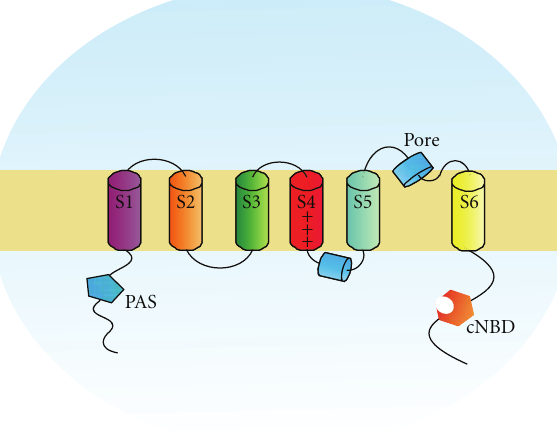
Figure 4: VEGF receptors and their ligands.